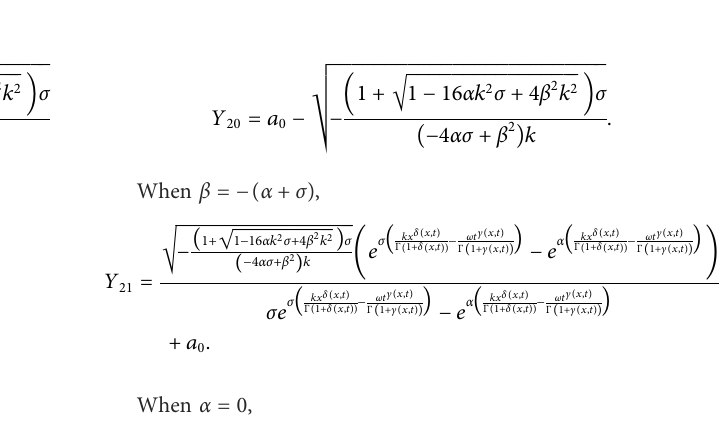
, γ ( x , t ) (cid:2) 2 cos ( xt )+( xt ) 2